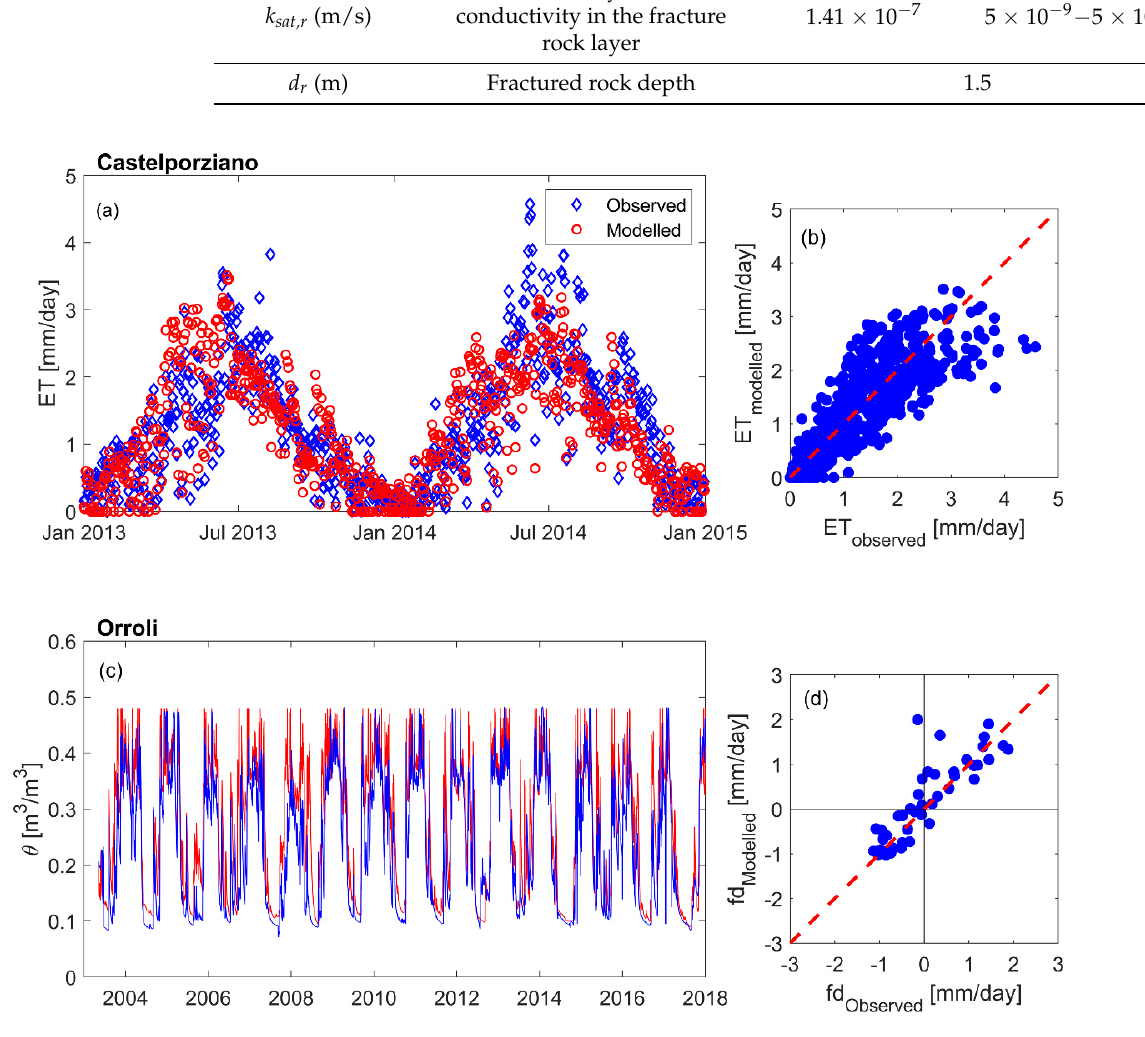
Figure 6. Model results at the two further experimental sites: ( a ) and ( b ) comparison of observed and predicted evapotranspiration (ET) at the Castelporziano site; ( c ) comparison between observed and predicted soil moisture ( q ) at the Orroli site in Sardinia; ( d ) comparison between seasonal predicted and observed hydraulic redistribution flux between the surface soil and the underlying fractured rock through the tree roots ( f d ) at the Orroli site.